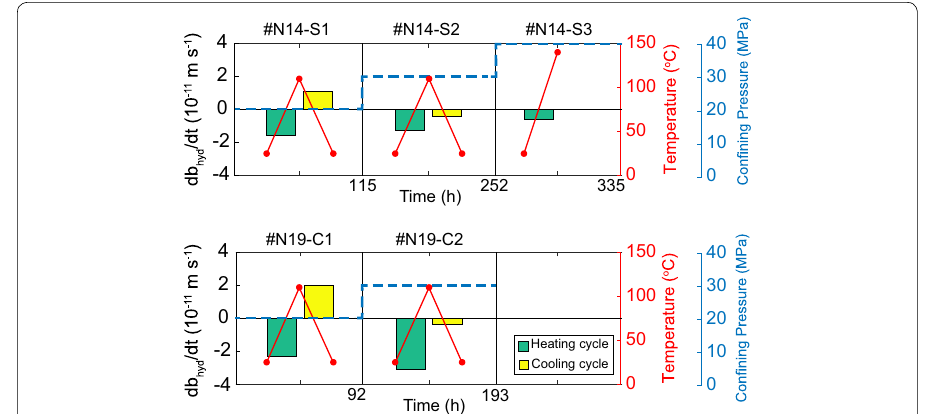
Fig. 8 Fracture closure rates. Rates of aperture closure, derived from hydraulic measurements ( d b hyd / d t ). A negative rate sign indicates that the cycle leads to fracture closure, while a positive rate sign indicates that the cycle leads to fracture